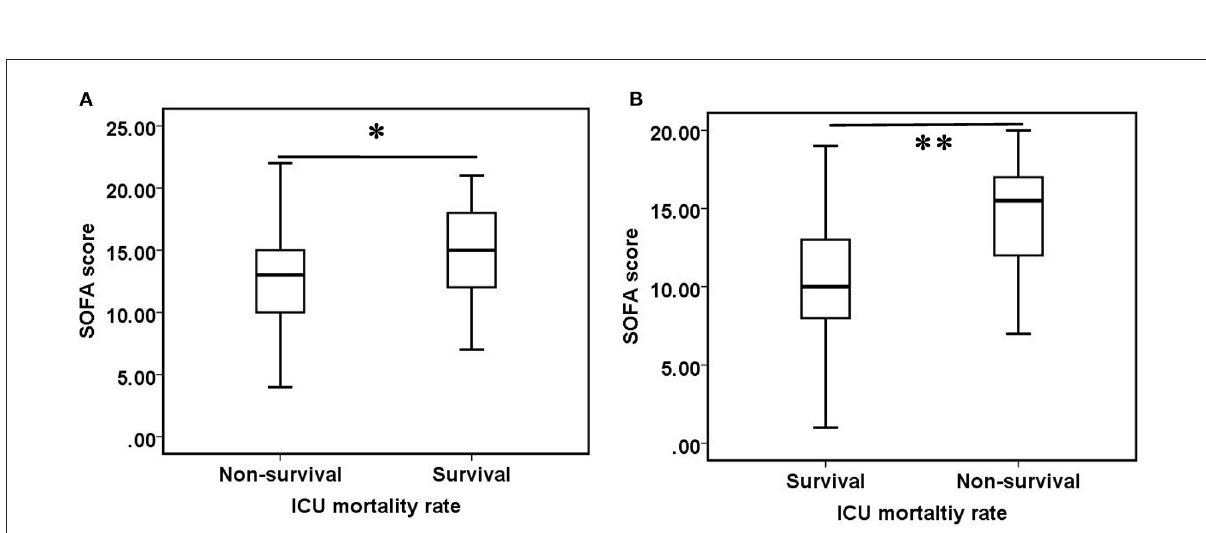
FIGURE3 Comparison of SOFA scores between survival and non-survival groups. (A) Before oXiris-CHFA treatment (0h), (B) after oXiris-CHFA treatment (24h). *P = 0.064, **P <